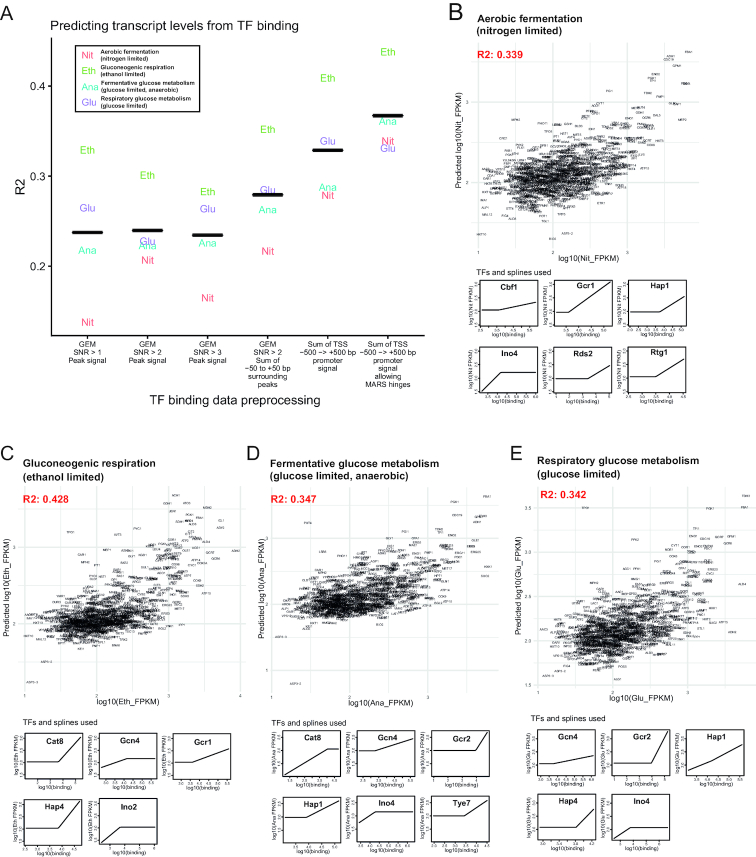
Comparing performance of TF binding data preprocessing in linear regressions to predict transcript levels and details of multivariate adaptive regression splines (MARS) models. (A) Correlations between predicted transcript levels and real transcript levels for the different formats of TF binding data. The black line indicates the mean of the four metabolic conditions. (B–E) MARS used to predict metabolic gene transcript levels of the different conditions from the amount of TF binding per gene promoter. The boxes shown below the predictions plots represent the different TFs that are selected by MARS to give strongest predictive performance in the conditions and how their signal is contributing to predictions in the model.